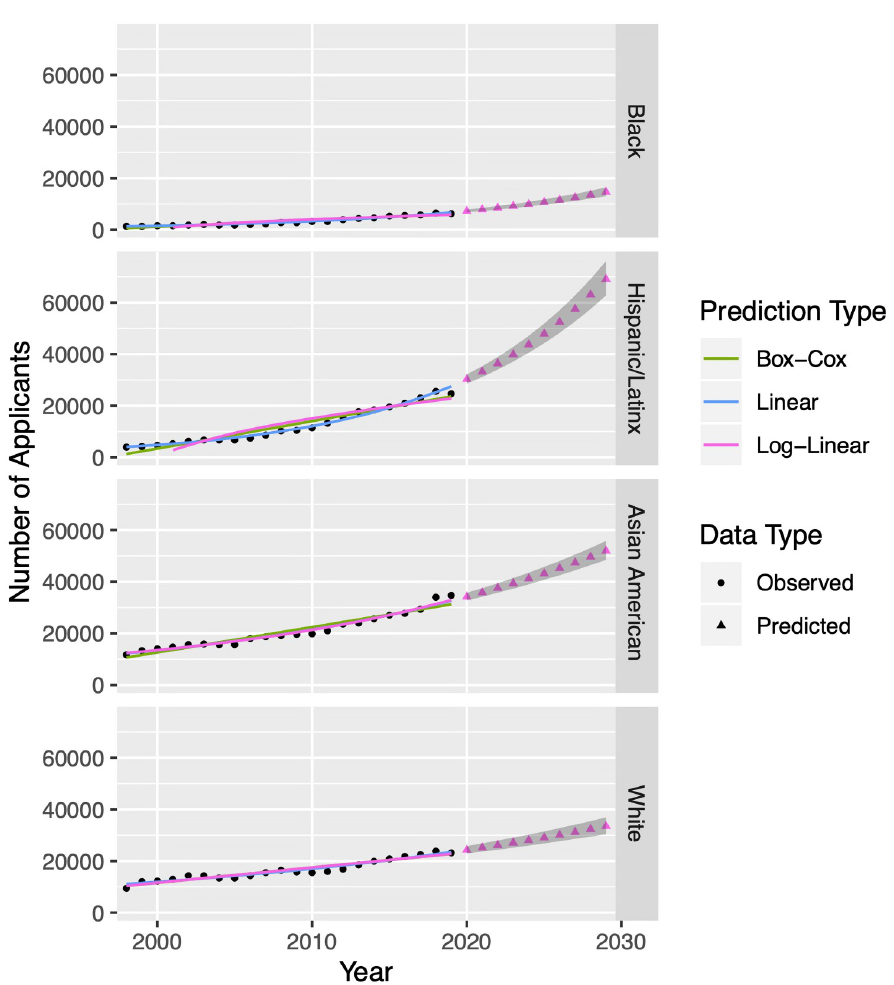
Fig 3. Regression models for applicant data from University of California-Berkeley. To model applicant data in each of four racial/ethnic groups from 1998—2019 (black dots) we apply three potential regression models, namely optimal Box-Cox (green), linear (blue) and log-linear (pink) to observed data from the University of California system [10]. We perform a standard residual analysis on each model in order to choose the best one. For the parameters depicted above, the best model happens to be log-linear for each. Table 1 provides our chosen fits for all applciation, acceptance, and enrollment parameters. Using our chosen models, we forecast data from 2020—2029 (triangles). The 95% confidence intervals on predicted values appear as gray bands. We will use these intervals later to generate 95% confidence intervals on the output of our Markov chain model. While the figure above shows fits for applicant counts, we follow a similar procedure for acceptance counts and enrollment counts; see Table 1. Note: if there is no optimal Λ for the Box-Cox transformation, the regression procedure defaults to linear. Hence, the linear and Box-Cox models sometimes